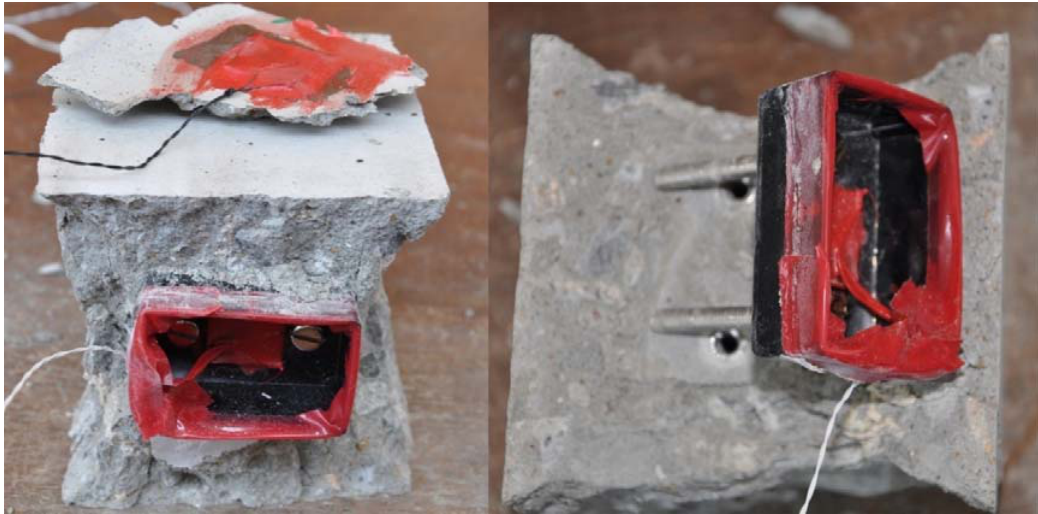
Figure 5. Reusable setup detached after compressive